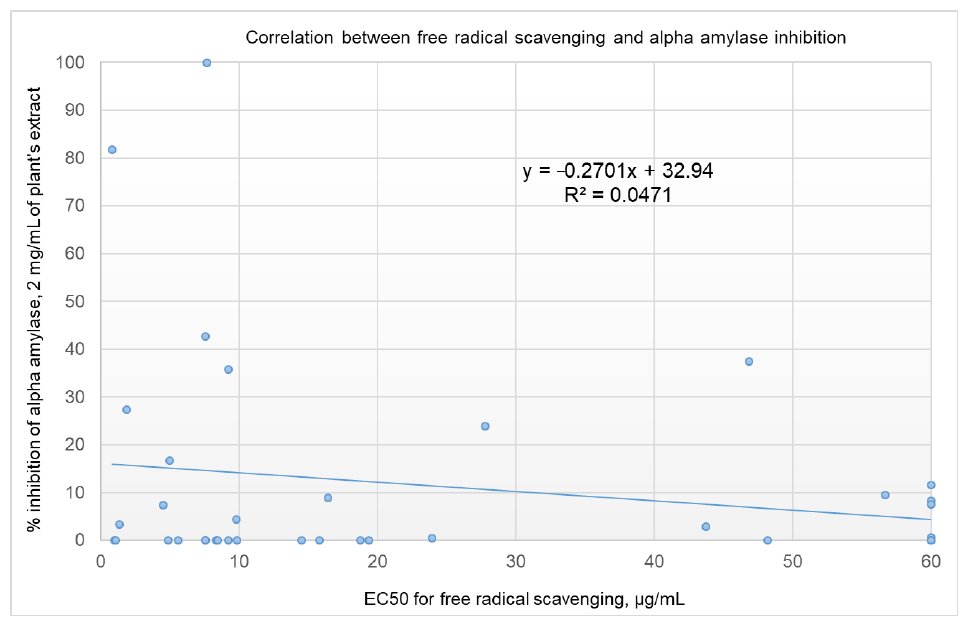
Figure 2. Correlation between the percentage of inhibition of α-amylase by 2 mg/mL of plant extract and the EC 50 for FRSA. A free radical scavenging EC 50 > 60 µg/mL is set at 60 µg/mL.